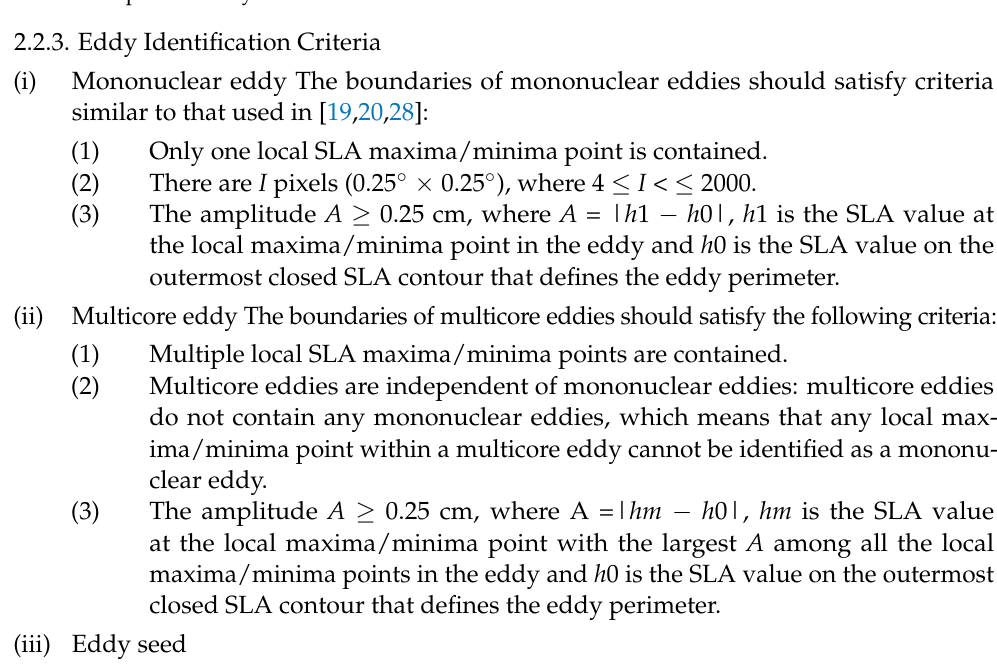
Figure 3. A diagram illustrating a merging event of counterclockwise-rotating (black solid line with arrow) anticyclonic eddies in the Northern Hemisphere. ( a ) Eddy1 in eddygroup1 and eddy2 in eddygroup2 approach each other; ( b ) eddy1 and eddy2 merge into the common eddygroup3; ( c ) eddy1 and eddy2 approach each other and eventually merge into eddy3 (a multicore eddy); ( d ) the local maxima points of eddy3 approach each other, eventually yielding a local maximum point. The eddy cores are represented by black dots.